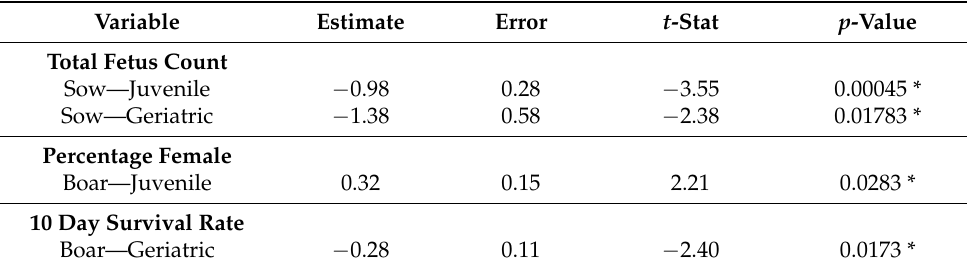
Figure 2. Kernel density estimation of guinea pig strain 13/N sow weight, by age at delivery and age group, as represented in the dataset. Sow weights followed a normal distribution with flatter curves, as expected, for juvenile (0 through 150 d, n = 19) and geriatric populations (older than 900 d, n = 7) due to the lower number of animals in those age categories relative to adults (151 through 900 d, n = 147). Table 5. Final significant factors determined by stepwise regression in strain 13/N guinea pig pregnancies, represented by sow and boar age at